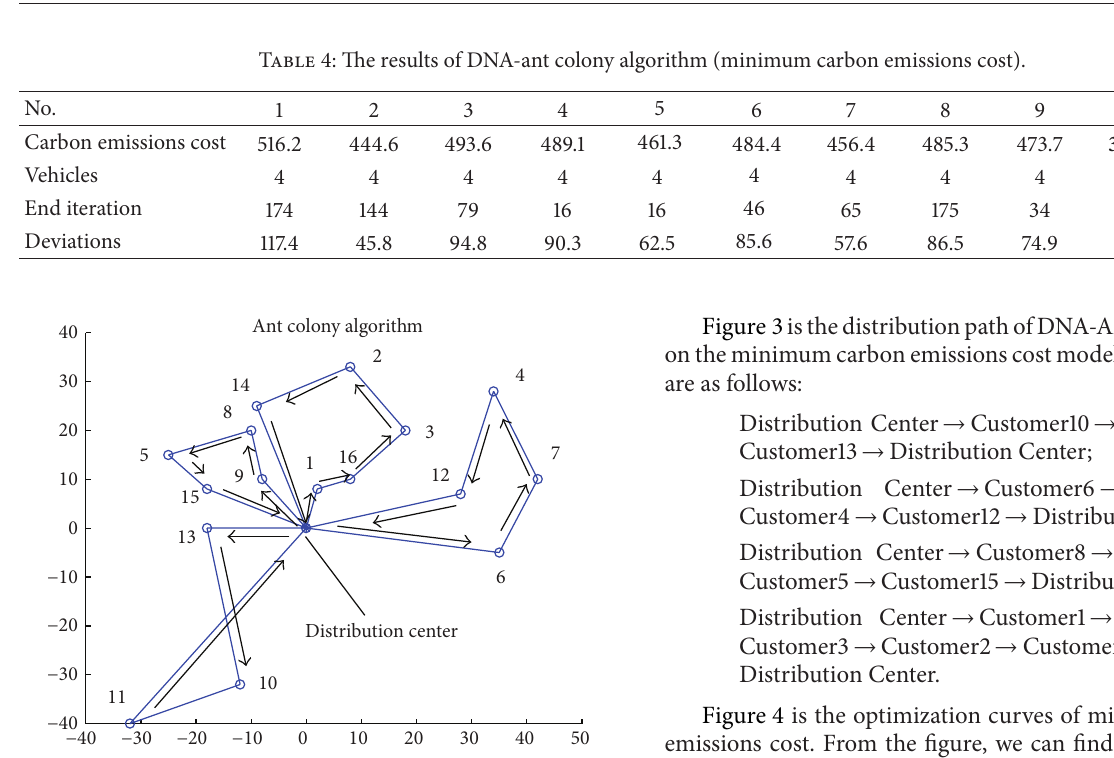
Figure 2: Distribution path basic ant colony algorithm (minimum carbon emissions